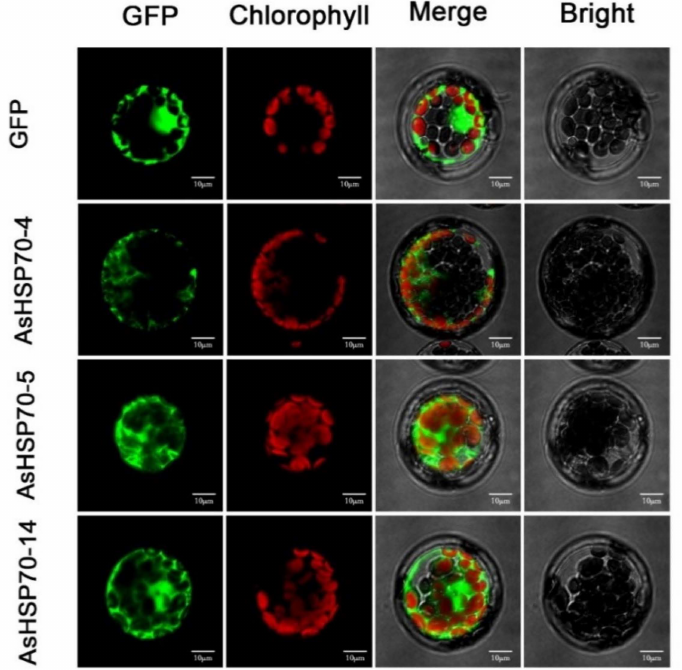
Figure 6. Subcellular localization of AsHSP70 proteins in Arabidopsis protoplast. The AsHSP70-4- pBWA(V)HS-GFP, HSP70-5-pBWA(V)HS-GFP, HSP70-14-pBWA(V)HS-GFP and pBWA(V)HS-GFP vectors were transiently expressed in Arabidopsis protoplast. Confocal images were acquired at 48 h. Scale bar = 10 µ